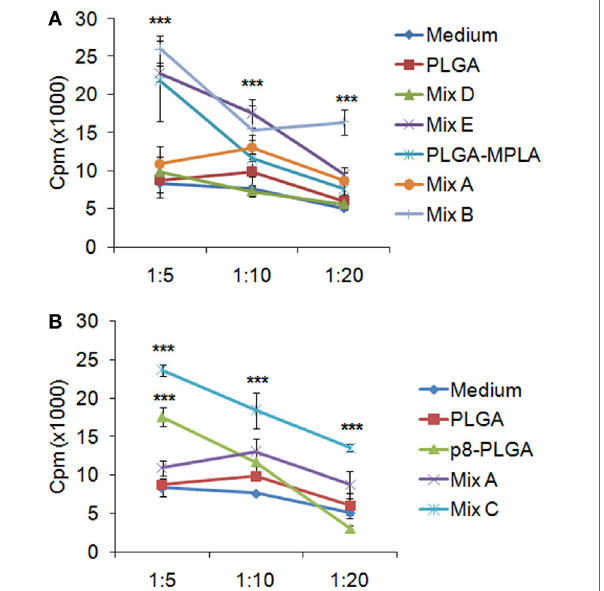
FigUre 6 | T cell priming induced by dendritic cells (DCs) stimulated with the differentially functionalized peptide-based poly(lactic- co -glycolic) acid (PLGA) nanoformulations. Spleen cells from naïve BALB/c mice were primed in vitro by DCs stimulated for 24 h with the mix of PLGA-chCPAp, PLGA-chH1p, and PLGA-KMP-11p nanoformulations (mix A), the mix of PLGA-chCPAp-MPLA, PLGA-chH1p-MPLA, and PLGA-KMP-11p-MPLA nanoformulations (mix B), the mix of p8-PLGA-chCPAp, p8-PLGA-chH1p, and p8-PLGA-KMP-11p nanoformulations (mix C), the mix of soluble chimeric peptides (mix D), and the mix of soluble chimeric peptides plus MPLA (mix E). Cultures were pulsed for the last 18 h with 1 μ Ci of 3 [H]-TdR, and the proliferative potential was measured by 3 [H]-TdR incorporation. The diagrams indicate the effect of MPLA incorporation (a) or the effect of surface modification with p8 (B) in the capacity of DCs stimulated with the mix B or the mix C to induce T cell priming. Samples were run in triplicates. Results are depicted as cpm ± SD from three independent experiments. Significant differences are indicated by *** p <